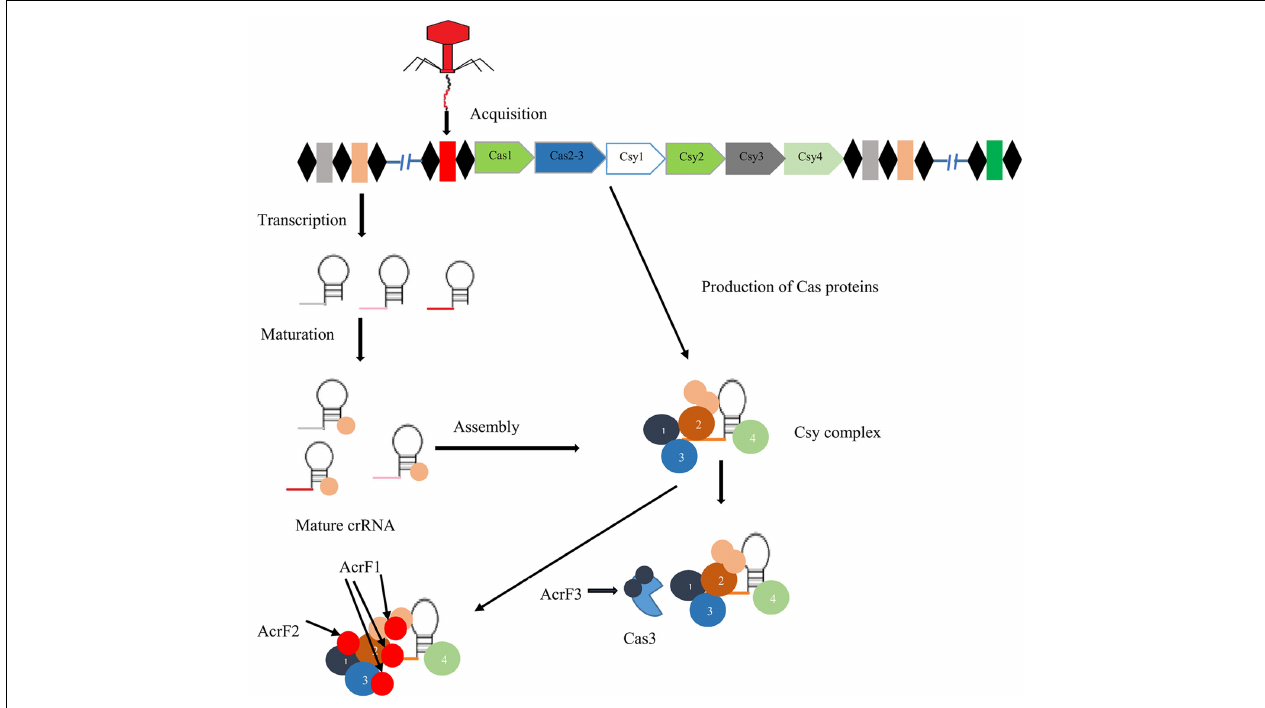
FIGURE 2 | Mechanism of action of three anti-CRISPR proteins. Black diamonds indicate direct repeats of CRISPR system type I-F separated by spacer sequences (colored boxes). In the presence of cas1,2 proteins, foreign DNA (red box) is acquired at the CRISPR locus. After that biogenesis of crRNA, mature crRNA forms in response to pre-crRNA transcription. crRNA-Csy complex binding with Csy1, Csy2, and Csy3, results in the formation of surveillance complex. Anti-CRISPR proteins AcrF1 and AcrF2 interact directly with this complex and block the binding of DNA. AcrF3 interacts with Cas3 nuclease protein and prevents its recruitment (Maxwell,